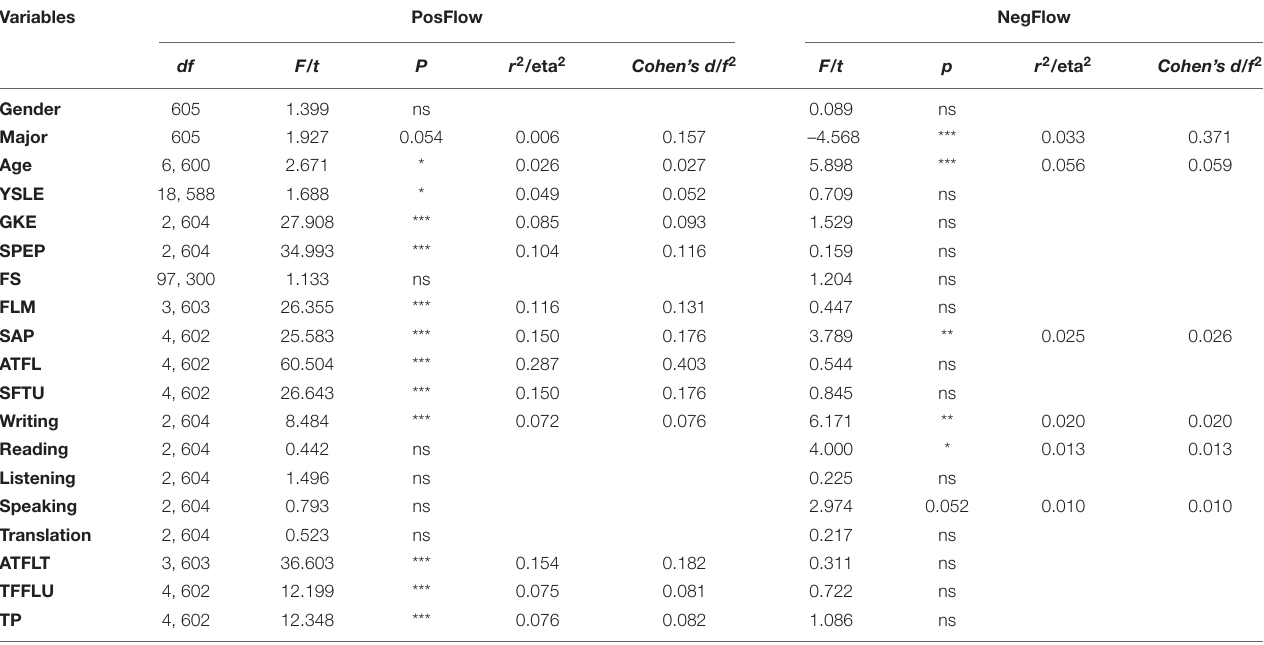
TABLE 3 | Overview of the effects of the independent variables on PosFlow and NegFlow. Variables PosFlow NegFlow